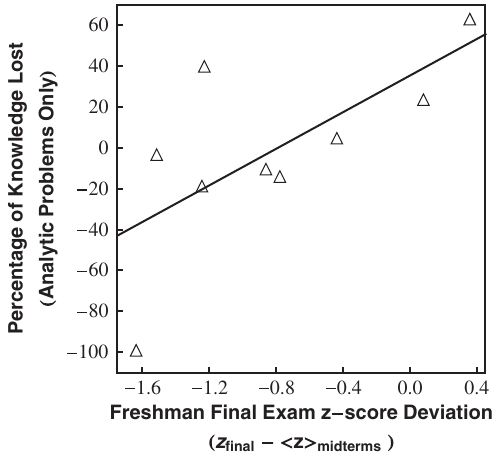
FIG. 8. Plot of percentage loss on analytic questions versus deviation of final exam z score from mean midterm z score for group 3 students. The y intercept of the linear fit is 35% (cid:5) 20% .